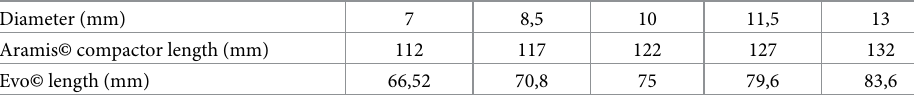
Table 1. Length of Aramis © compactor and Evo ©